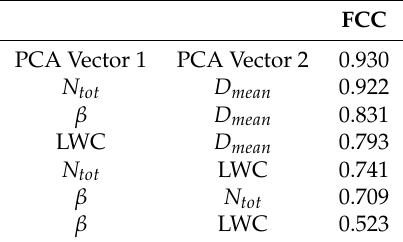
Table 4. Global fog correlation